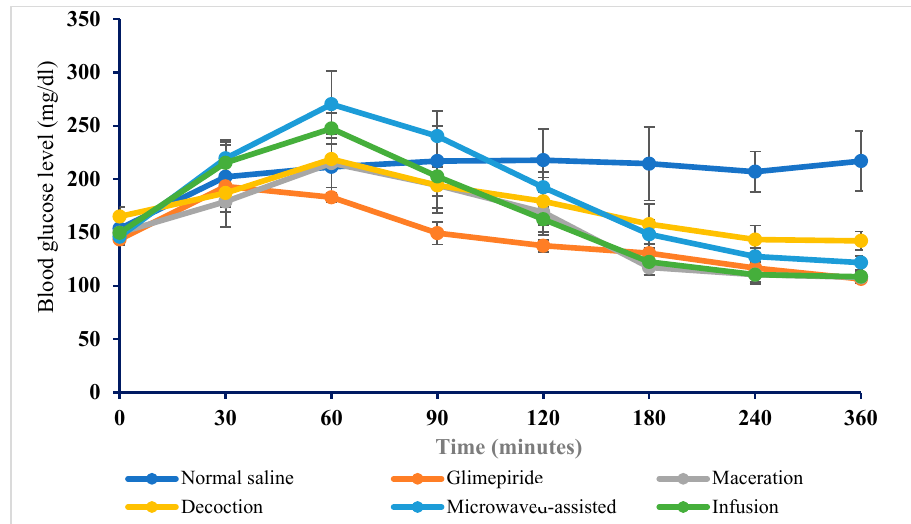
Figure 5. The change in blood glucose level in diabetic mice induced by a single dose of 250 mg/kg Terfezia claveryi extracts and glimepiride . Each bar represents the mean ± SEM for ( n = 6) mice per treated group.